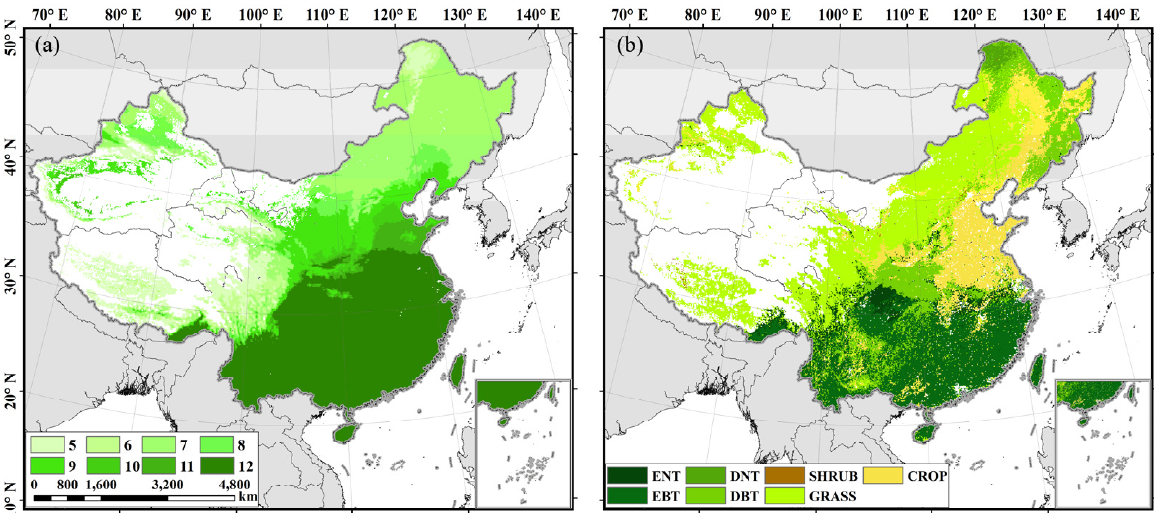
Figure 1. The spatial distribution of vegetation growing season duration ( a ) and the corresponding vegetation distribution ( b ) in China. The colors in ( a ) show the duration of the growing season in months, and the colors in ( b ) show the vegetation types based on the Plant Functional Types classification, including evergreen needle-leaf trees (ENT), evergreen broadleaf trees (EBT), deciduous needle-leaf trees (DNT), deciduous broadleaf trees (DBT), shrubland, and grassland. The pixels with an annual mean normalized difference vegetation index (NDVI) over 18 years lower than 0.1 are in black.